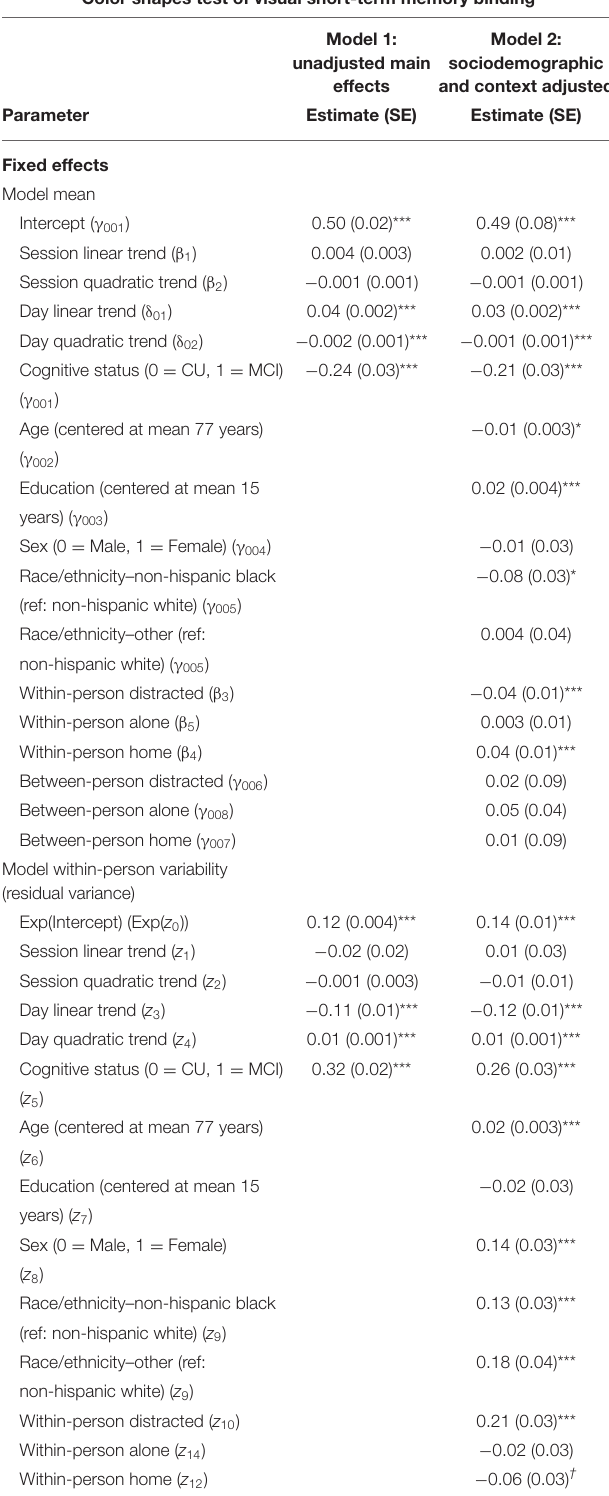
TABLE 3 | Heterogeneous variance models examining cognitive status differences in mean and variability in color shapes performance. Color shapes test of visual short-term memory